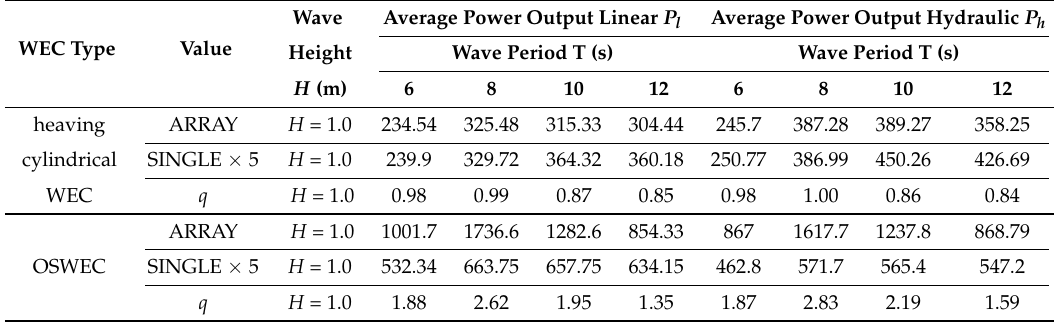
Table 5. Average power output for an array of 5 WECs for a linear and hydraulic PTO system. heaving cylindrical WEC: top three rows. OSWEC: bottom three